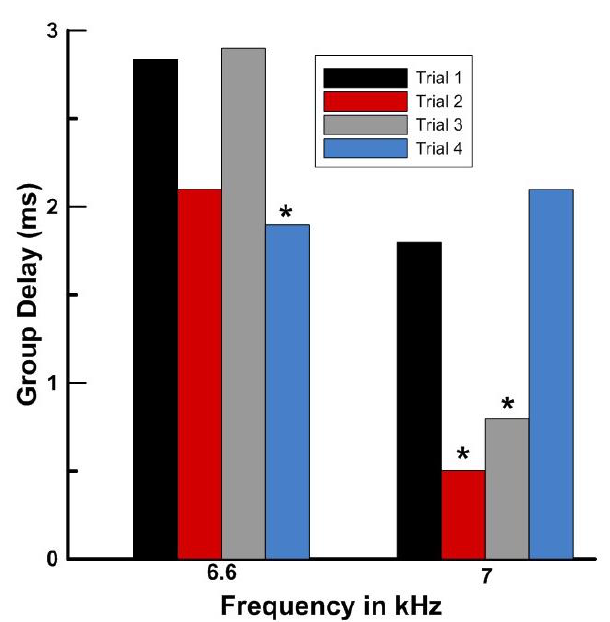
Figure 4. Weighted group delays for patient 7 at the highest (right) and the second highest (left) frequency with present DPOAEs. Black bars indicate session 1, red bars indicate session 2, grey bars indicate session 3, and blue bars indicate session 4. Session and trial are synonymous. * Indicates defined significant difference from baseline.